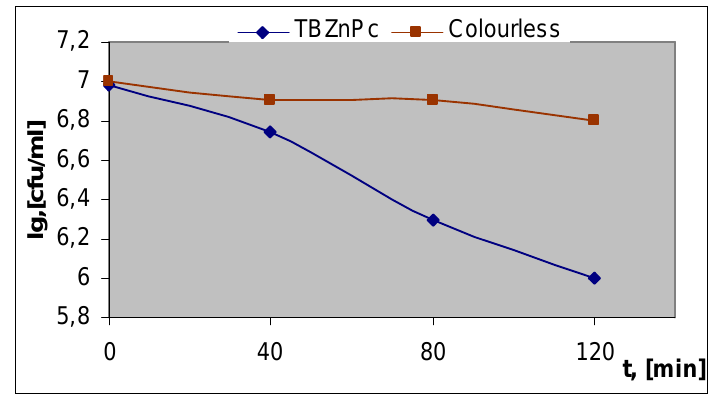
FIGURE 8. Kinetics of photodisinfection of a microbial solution using the TBZnPc